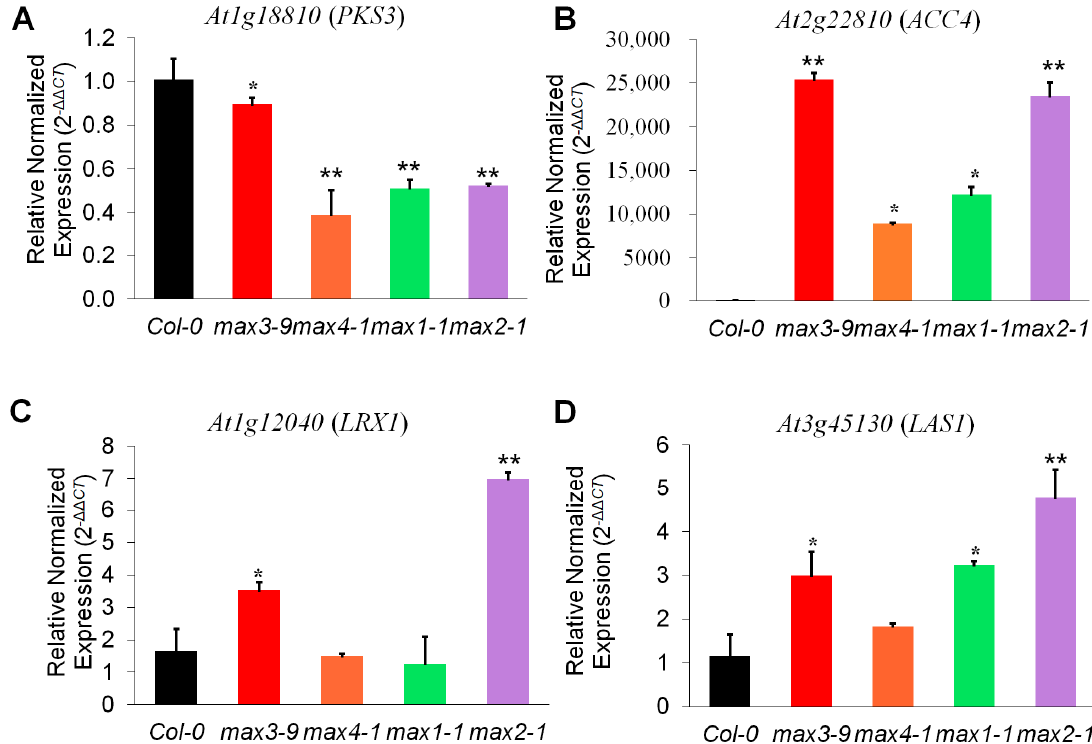
Figure 4. Differentially expressed genes in max2 mutants. ( A – D ) Relative normalized gene expression compared to wild-type in the max mutant. Error bars represent standard error of three replicates. Leaf of the mature plant was used to isolate RNA. The star indicates a significant difference between mutant and wild-type. * p < 0.05, ** p < 0.01 (Student’s t -test).